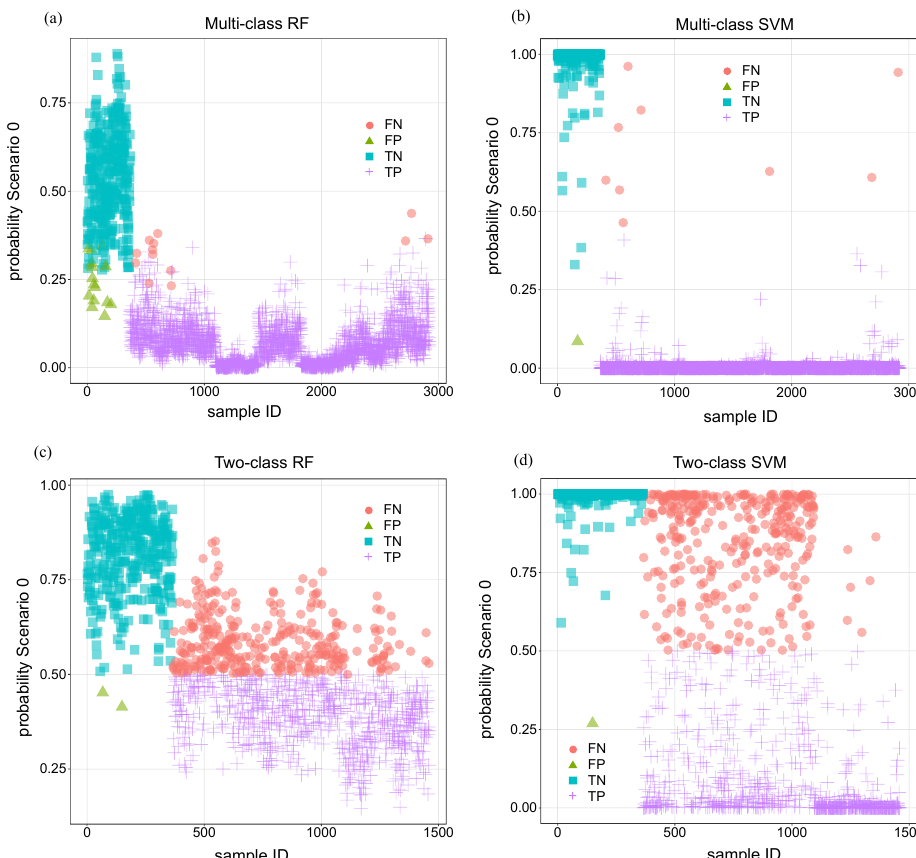
Figure 10. Predicted probability of belonging to Scenario 0. ( a ) RF multi-class. ( b ) SVM multi-class. ( c ) RF two-class. ( d ) SVM